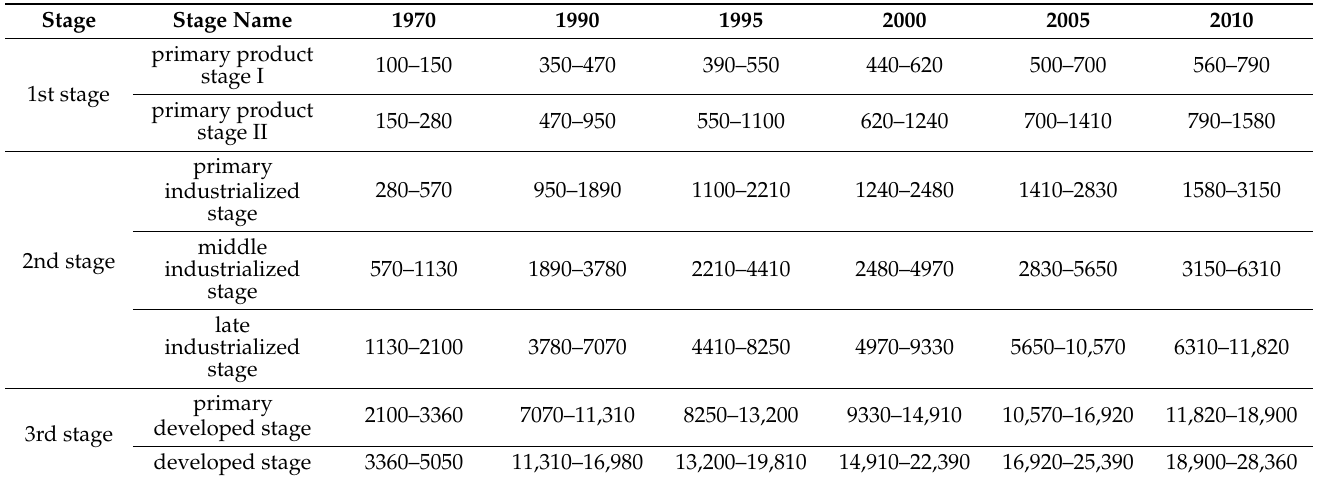
Table 6. Classification criterion of economic development stages by